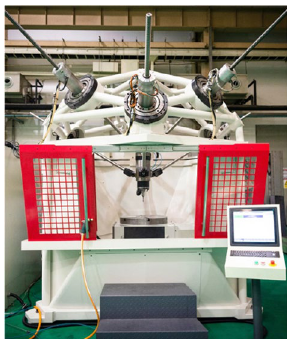
Figure 21 Five-axis milling robot Diarom-600